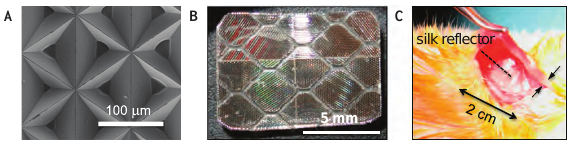
Fig. 2. (A) SEM image of a silk microprism reflector. (B) A microprism array prepared for implantation. (C) The reflector is implanted below mouse skin in the dorsal area. Reprinted from [37], Copyright (2012) National Academy of Sciences,